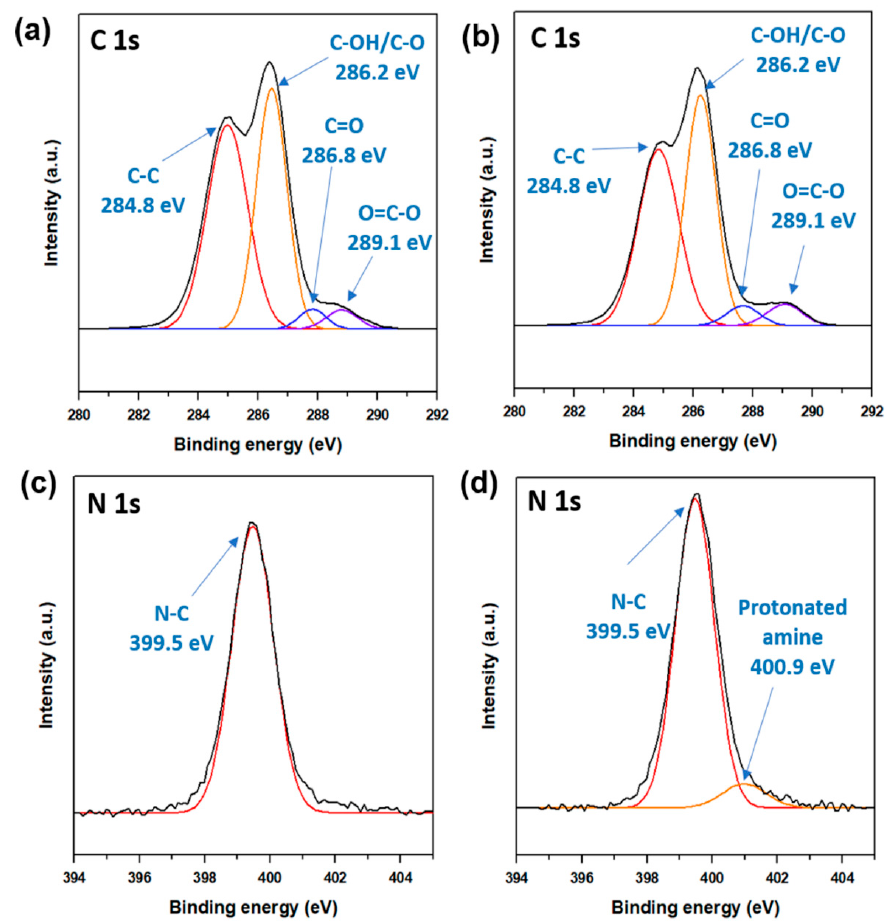
Figure 3. X-ray photoelectron spectroscopy (XPS) deconvolution results of WSPU: ( a ) C1s of WSPU without DMPA, ( b ) C1s of WSPU with 4% DMPA, ( c ) N1s of WSPU without DMPA and ( d ) N1s of WSPU with 4% DMPA. Polymers 2019 , 11 , x FOR PEER REVIEW